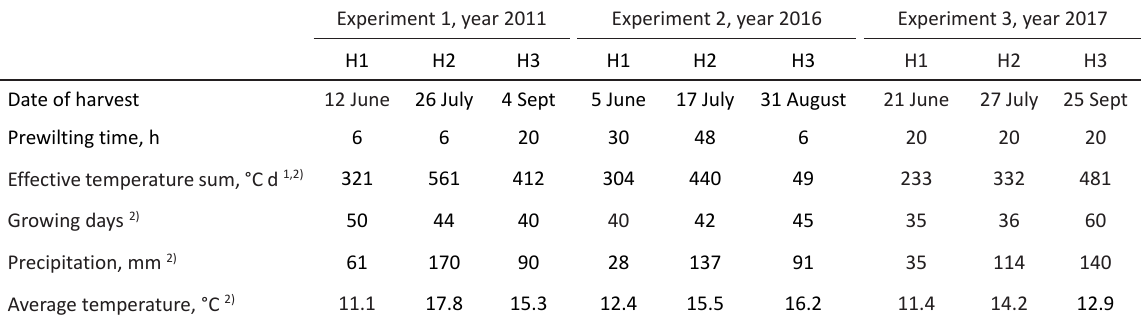
Table 2. Dates of harvests, prewilting times (h), growing days and descriptive weather statistics during the growing seasons for first (H1), second (H2) and third cut (H3) of grass silage across different